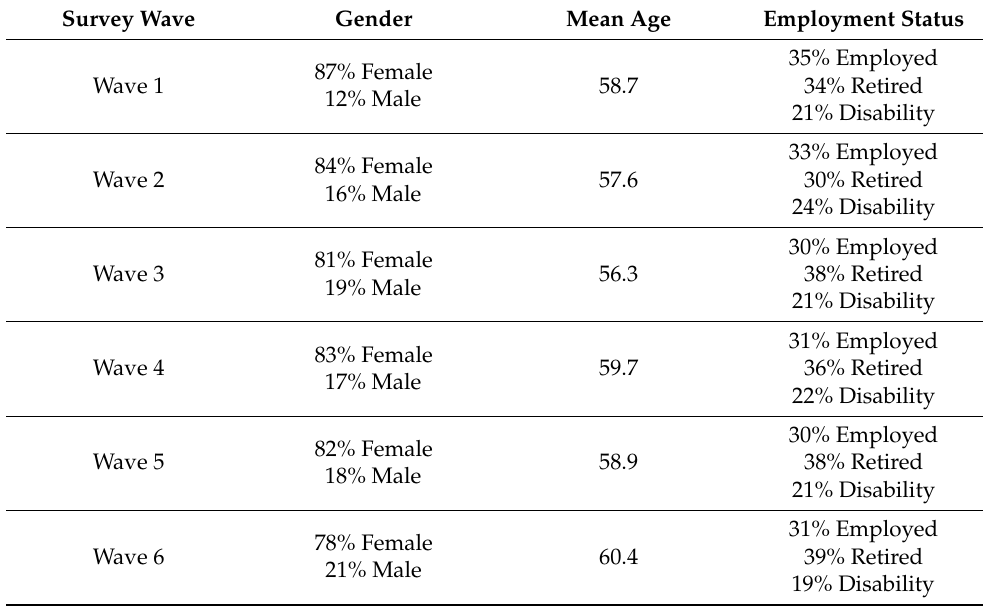
Table 2. Survey participants; select demographics per